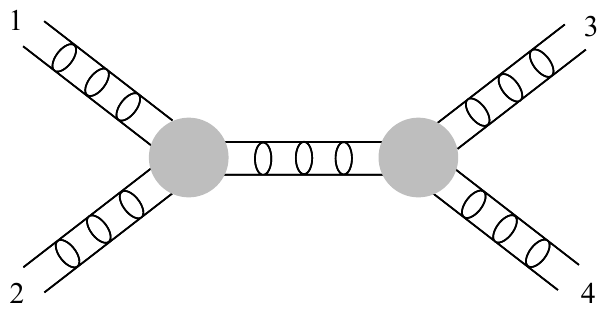
Figure 2. The fermion eight-point function is composed of Feynman diagrams such as the one shown. It is built out of two six-point functions; the shaded circle is de(cid:12)ned by (cid:12)gure